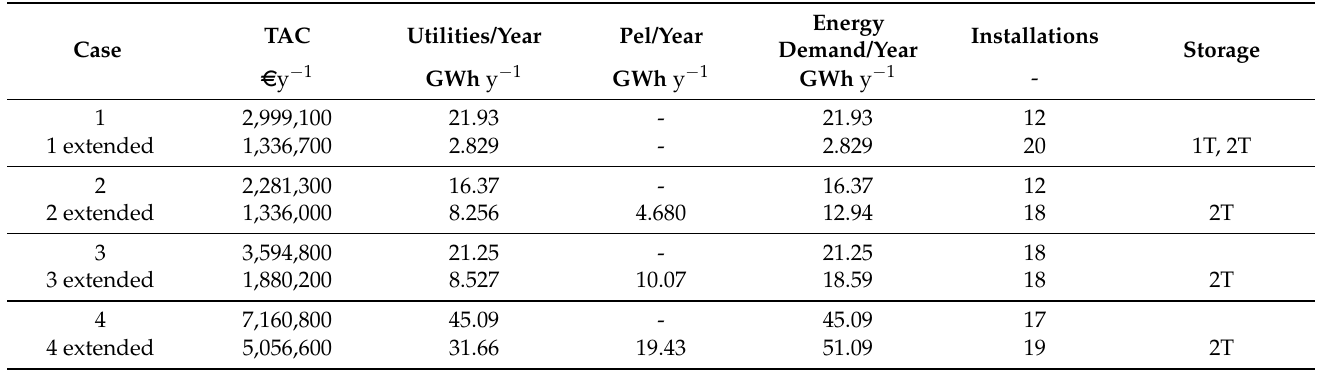
Table 13. Summary of optimization